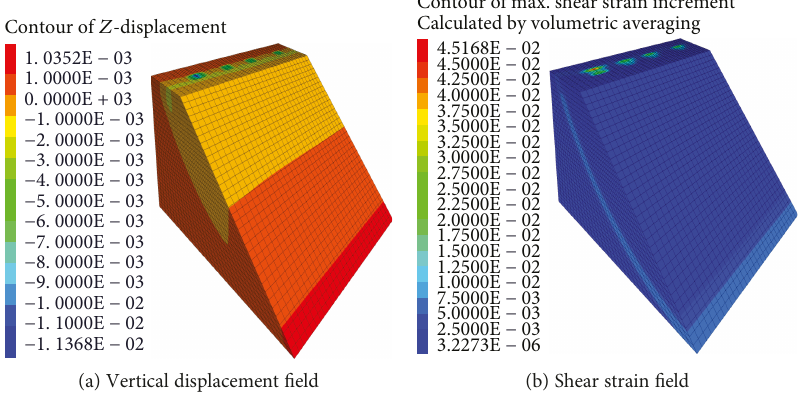
Figure 23: Vertical displacement fi eld and shear strain fi eld after loading 100 kg.